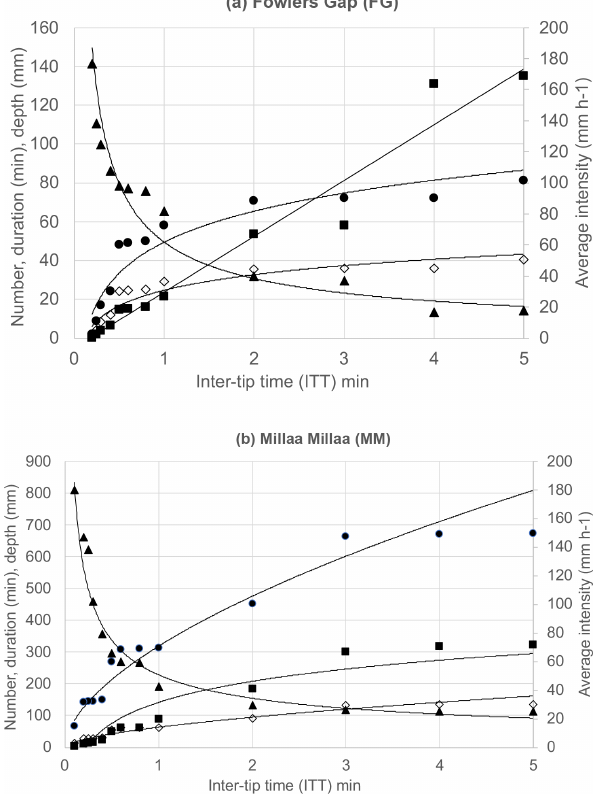
Figure 5. Data showing the characteristics of the longest run of ITTs not exceeding fixed thresholds of up to 5min, for the rainfall records at Fowlers Gap (FG) (a) and for Millaa Millaa (MM) (b) . The average intensity of the longest run (solid triangle symbols) is plotted against the right-hand axis; the number of tip events in the longest run (solid circle symbols), the duration of the longest run (in minutes, solid square symbols), and the rainfall depth delivered by the longest run (open diamond symbols) are plotted against the left-hand axis.